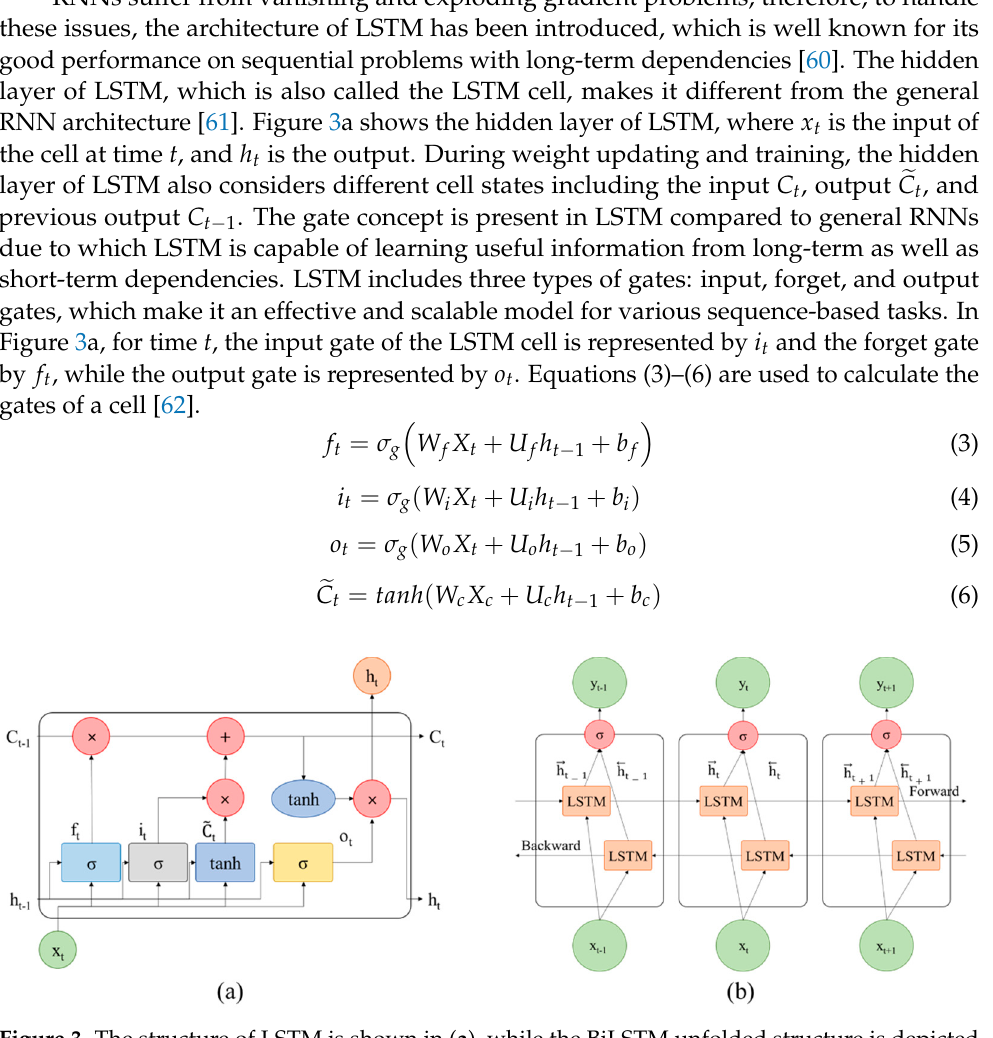
Figure 3. The structure of LSTM is shown in ( a ), while the BiLSTM unfolded structure is depicted in ( b ). in ( b